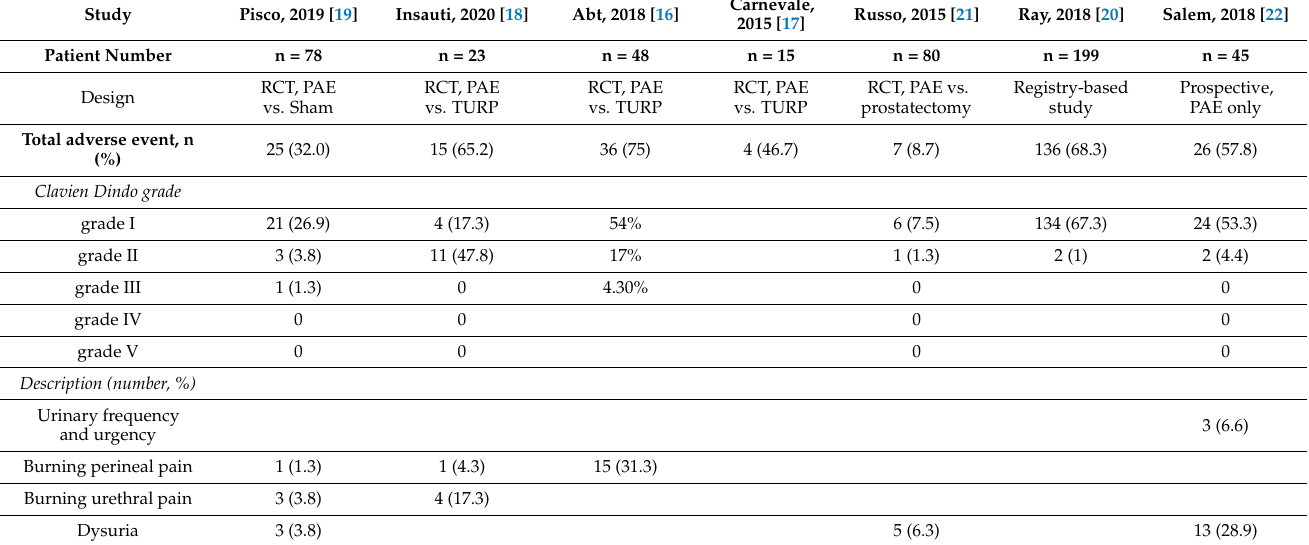
Table 1. Adverse events after PAE from seven prospective studies